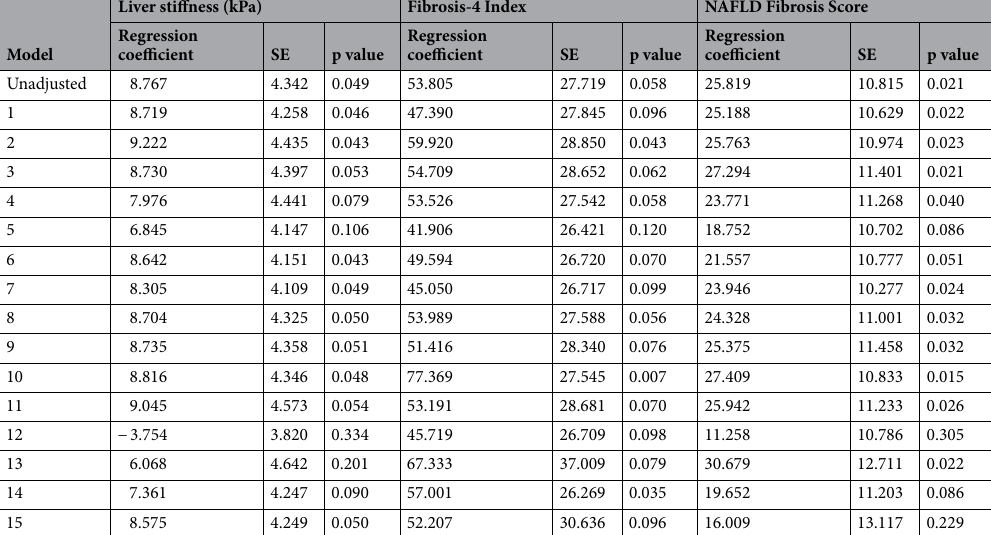
Table 2. Multiple regression analysis with epicardial adipose tissue as the outcome variable. SE standard error. Model 1: adjusted for sex. Model 2: adjusted for carbohydrate intolerance. Model 3: adjusted for diabetes. Model 4: adjusted for hypertension. Model 5: adjusted for dyslipidaemia. Model 6: adjusted for obstructive sleep apnoea syndrome. Model 7: adjusted for hyperuricemia. Model 8: adjusted for statin therapy. Model 9: adjusted for aspirin therapy. Model 10: adjusted for obesity. Model 11: adjusted for smoking. Model 12: adjusted for visceral adipose tissue. Model 13: adjusted for visceral adipose tissue/subcutaneous adipose tissue ratio. Model 14: adjusted for presence of carbohydrate intolerance, hypertension, dyslipidaemia, and obesity (number of factors). Model 15: adjusted for presence of carbohydrate intolerance/diabetes, hypertension,